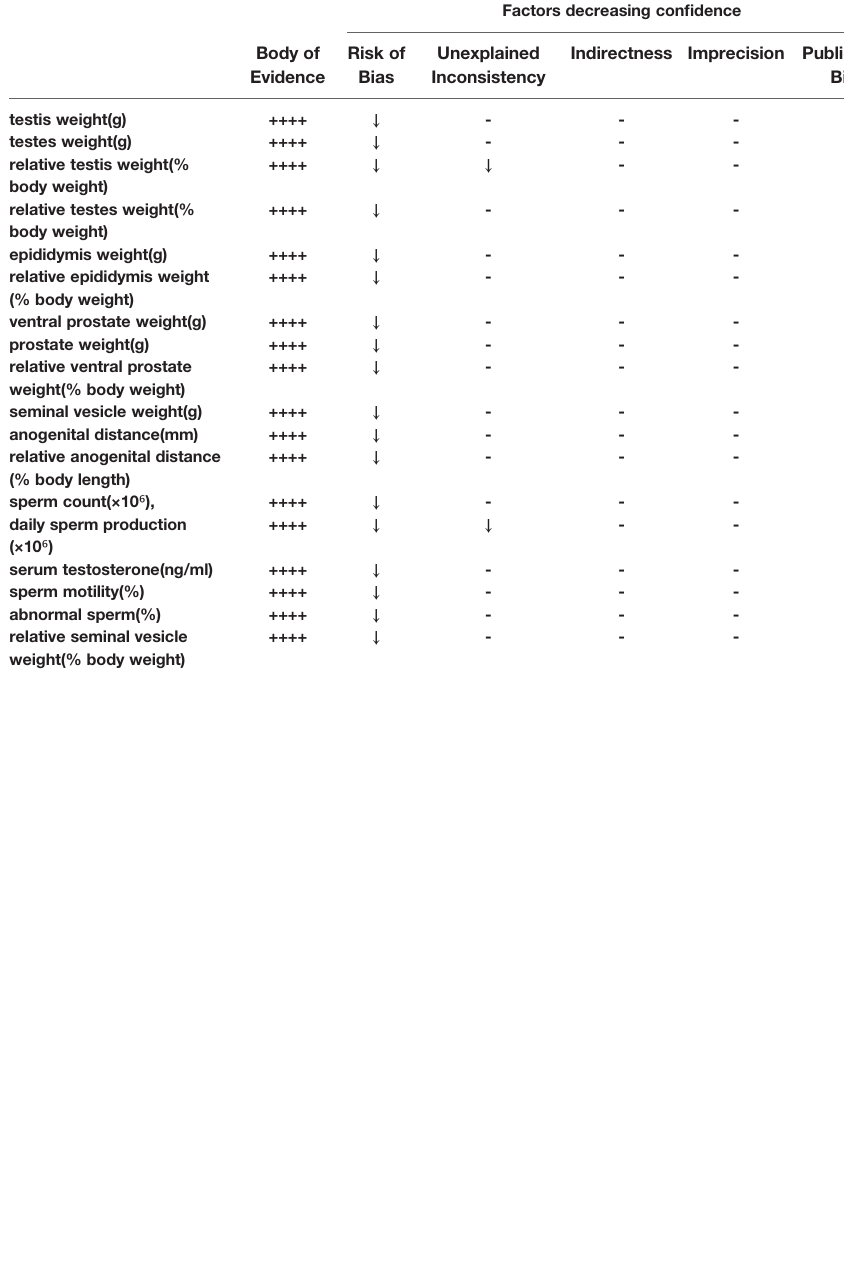
TABLE 4 | Outcomes of con fi dence rating and health effect